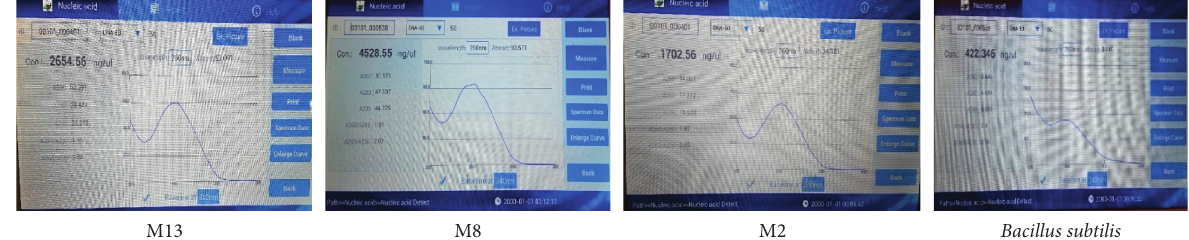
Figure 4: Quantification of DNA using nanodrop.